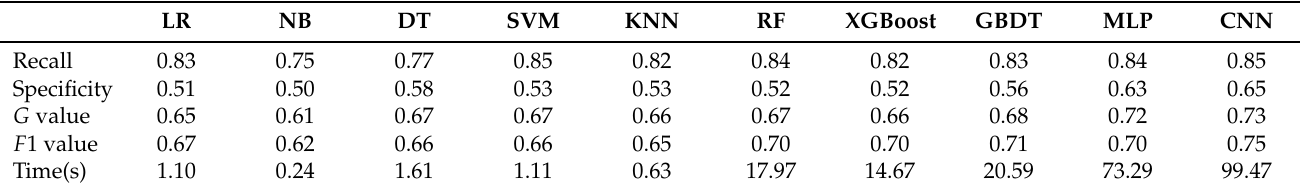
Table 11. Evaluation measures of each machine learning model in the normal and pathological voice class-imbalanced SVD dataset.